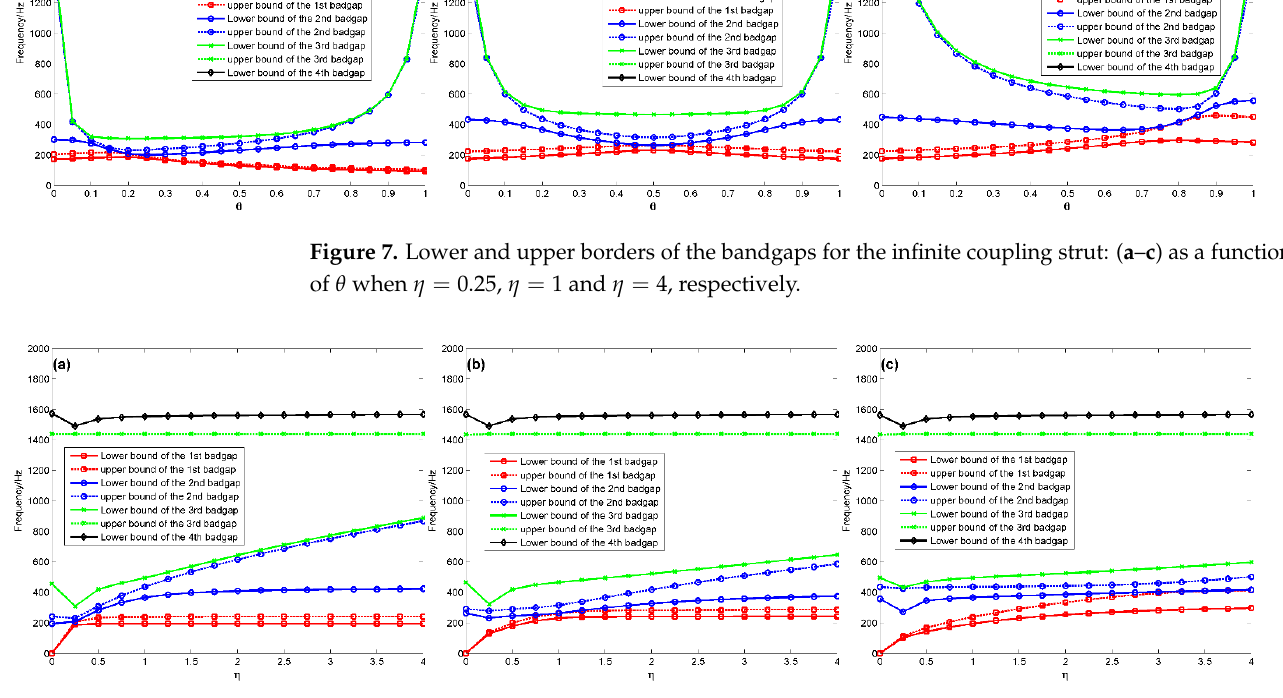
symbols, respectively.